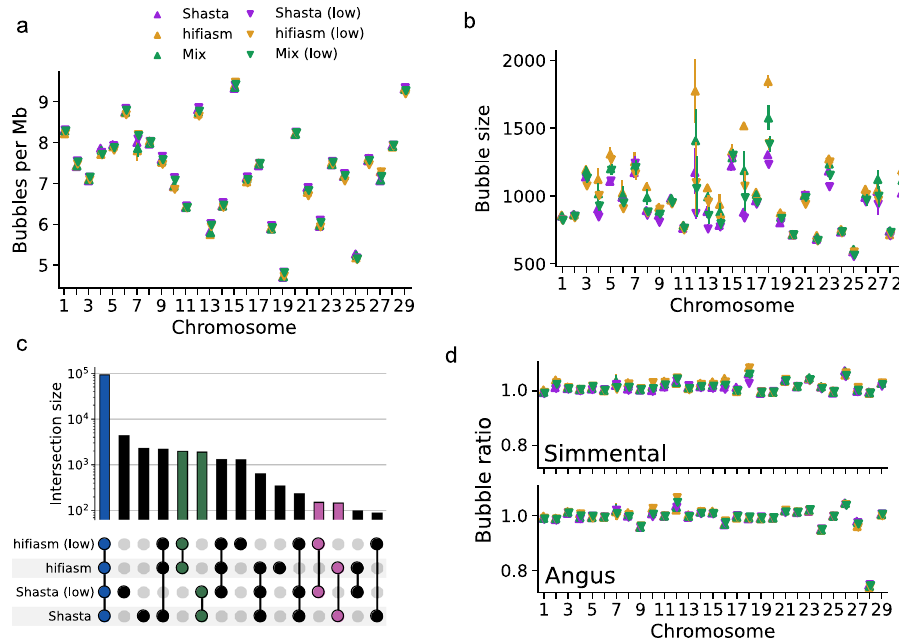
Fig. 4 Pangenomes are generally robust to different input assemblies. a The number of large (>1 Kb) bubbles is highly consistent across hi fi asm, Shasta, and mixed pangenomes at both full (up triangles) and lower (down triangles) coverages. b The mean bubble size is also consistent across different inputs, but bubbles are larger on average in hi fi asm pangenomes compared to Shasta pangenomes. c The vast majority (84.5%) of SVs identi fi ed through minigraph are present in all pangenomes (blue). SVs unique to either hi fi asm or Shasta (green) only account for about 3.5% of all SVs, while SVs only identi fi ed through either full or lower coverage pangenomes are negligible (pink). d Comparing the number of bubbles present in Simmental- or Angus- backed pangenomes to the ARS-UCD1.2-backed pangenome in a) shows consistency. Angus chromosome 28 is the only exception due to its incomplete sequence. All points re fl ect the mean over 20 stochastic pangenome constructions, and error bars indicate the 95% con fi dence